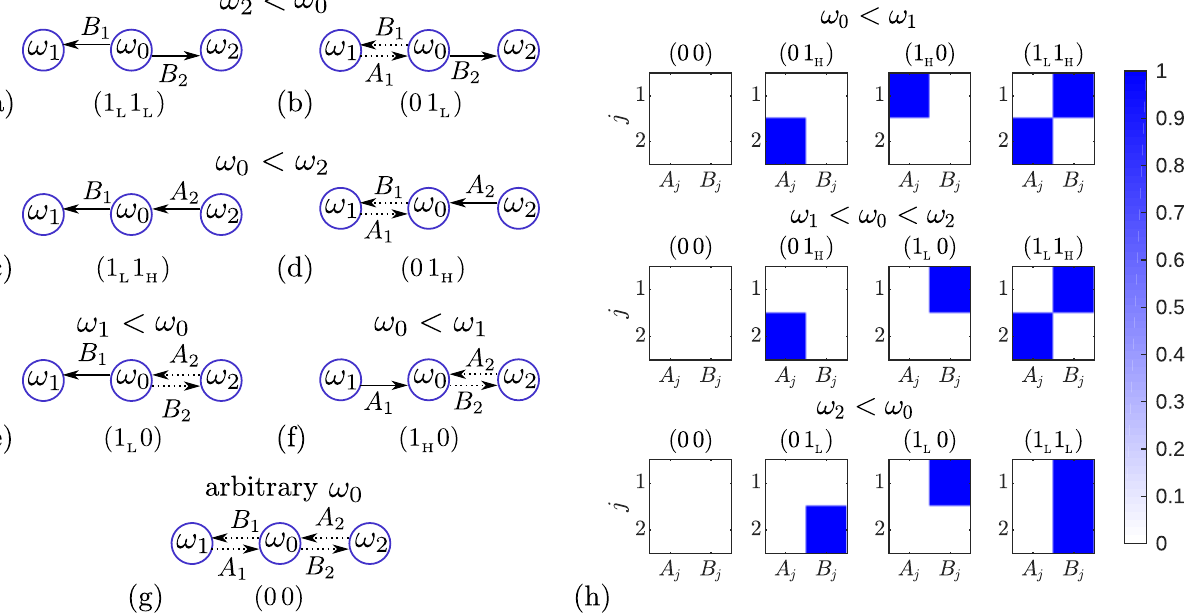
Figure 4. Asymptotic configurations for a two-leaf star network. ( a – g ) Predicted configurations. Solid arrows show the unidirectional coupling with maximum synaptic weight that results in synchronization between the leaf and the hub. Dashed arrows correspond to a weak synaptic connections, so the leaf is not synchronized with the hub. The required frequency inequality is indicated above each configuration. The two characters in brackets under each configuration represent its code. ( h ) Distributions of color-coded asymptotic values of coupling weights A j and B j for a two-leaf star network, obtained by integrating Eqs. (3) and (6). The results presented in three rows correspond to three different possibilities of the hub frequency to fall into different frequency intervals of the leaves: ω 0 < ω 1 (top row), ω 1 < ω 0 < ω 2 (middle row), and ω 2 < ω 0 (bottom row). The top row of ( h ) (from left to right) match configurations ( g , b , e , a ). For the middle and bottom rows, the corresponding configurations are, respectively, as follows: ( g , d , e , c ) and ( g , d , f , c ). All frequencies are taken from the array 0.001 , and the parameter µ 0.01 corresponds to the sigmoid boundary (0.55, 0.85, 1). The parameter ε = = function (5). The values of the parameters α , τ and τ are the same as in Fig. − +